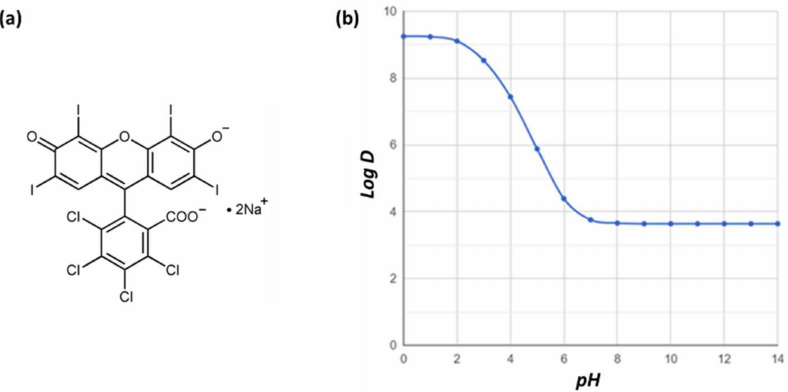
Figure 4. ( a ) Chemical structure of RB disodium salt. ( b ) LogD of RB as a function of pH was predicted using ChemAxon software (ChemAxon, Budapest, Hungary).